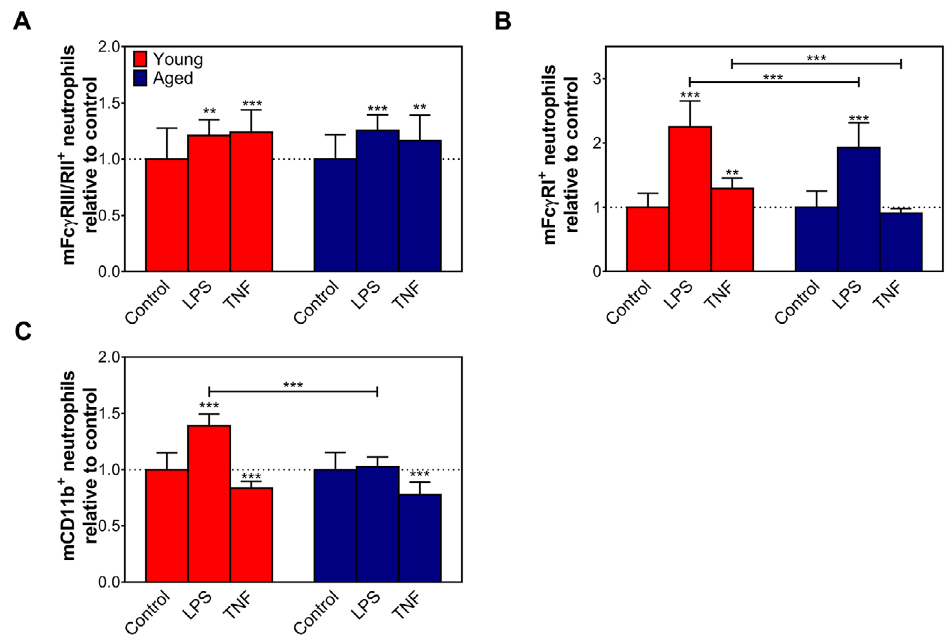
Figure 4- Young murine samples have higher FcγRI + and CD11 + neutrophils than aged mice after in vitro activation. The expression of (A) FcγRIII/FcγRII, (B) FcγRI, and (C) CD11b on purified neutrophils from young (red bars) and aged (blue bars) mice after 18 hours of treatment with LPS or TNF were determined by flow cytometry. Control=neutrophils cultivated without treatment. Data are shown as mean±SD. The results were evaluated by two-way ANOVA followed by Tukey’s and Sidak’s multiple comparisons test. **p≤0.01 and